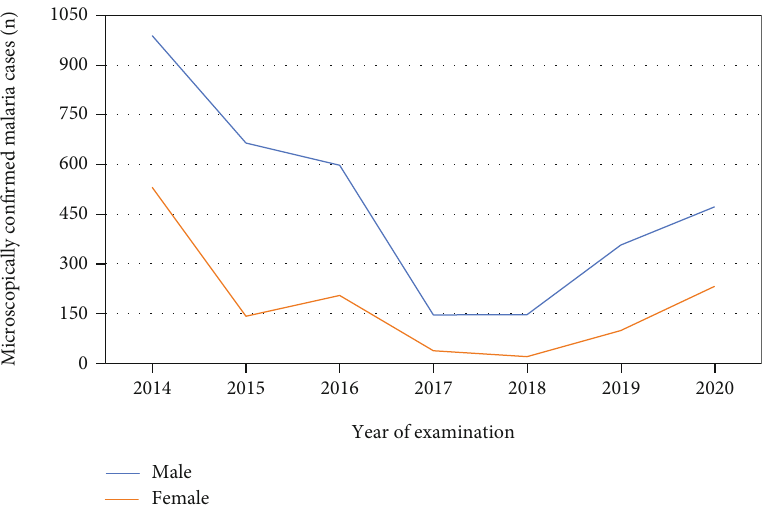
Figure 4: Trend analysis of malaria in relation to participants gender from 2014 to 2020 ( n = 28217